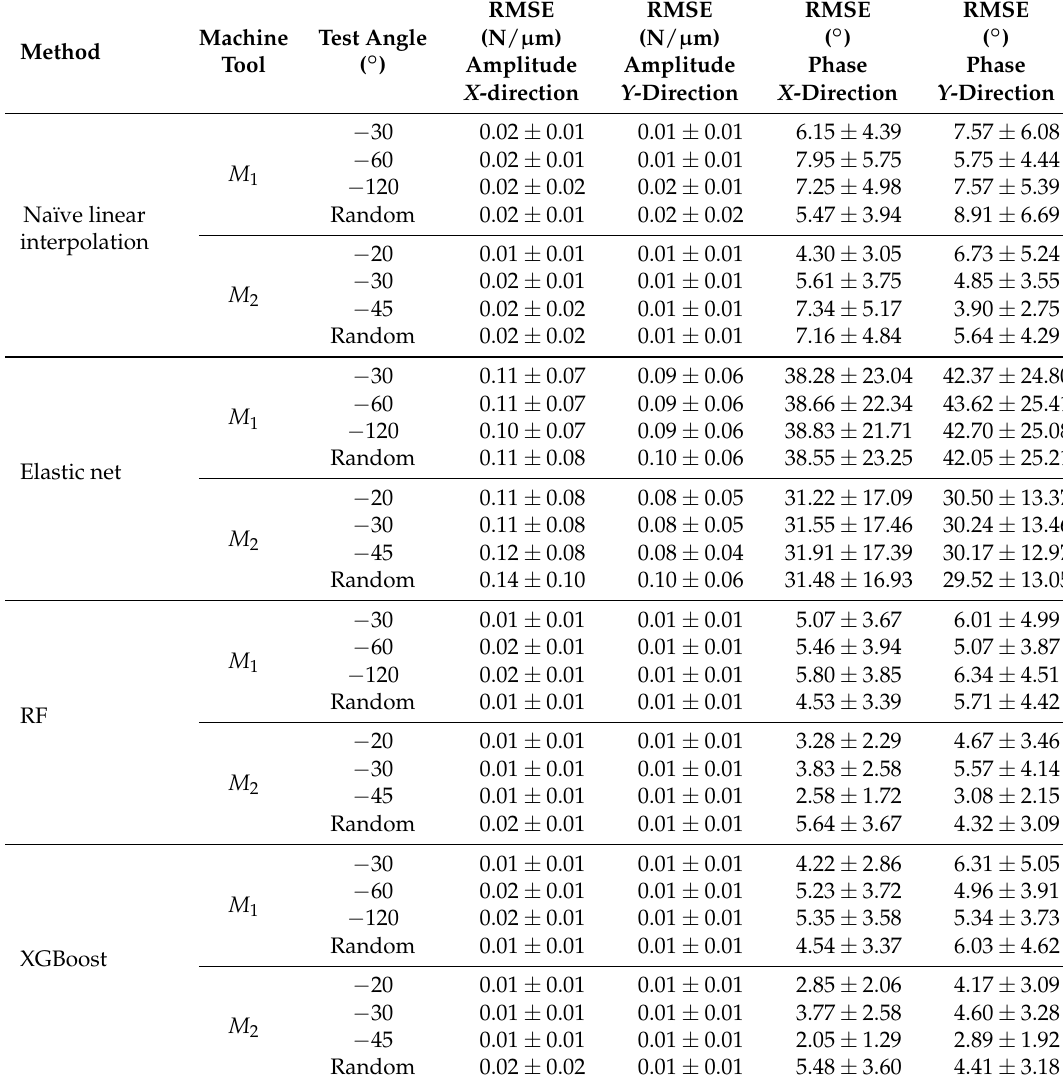
Table 4. Comparison between the root-mean-square error (RMSE) of predicted amplitudes and phases in X- and Y-direction of the machine coordinate system for two machine tools using different